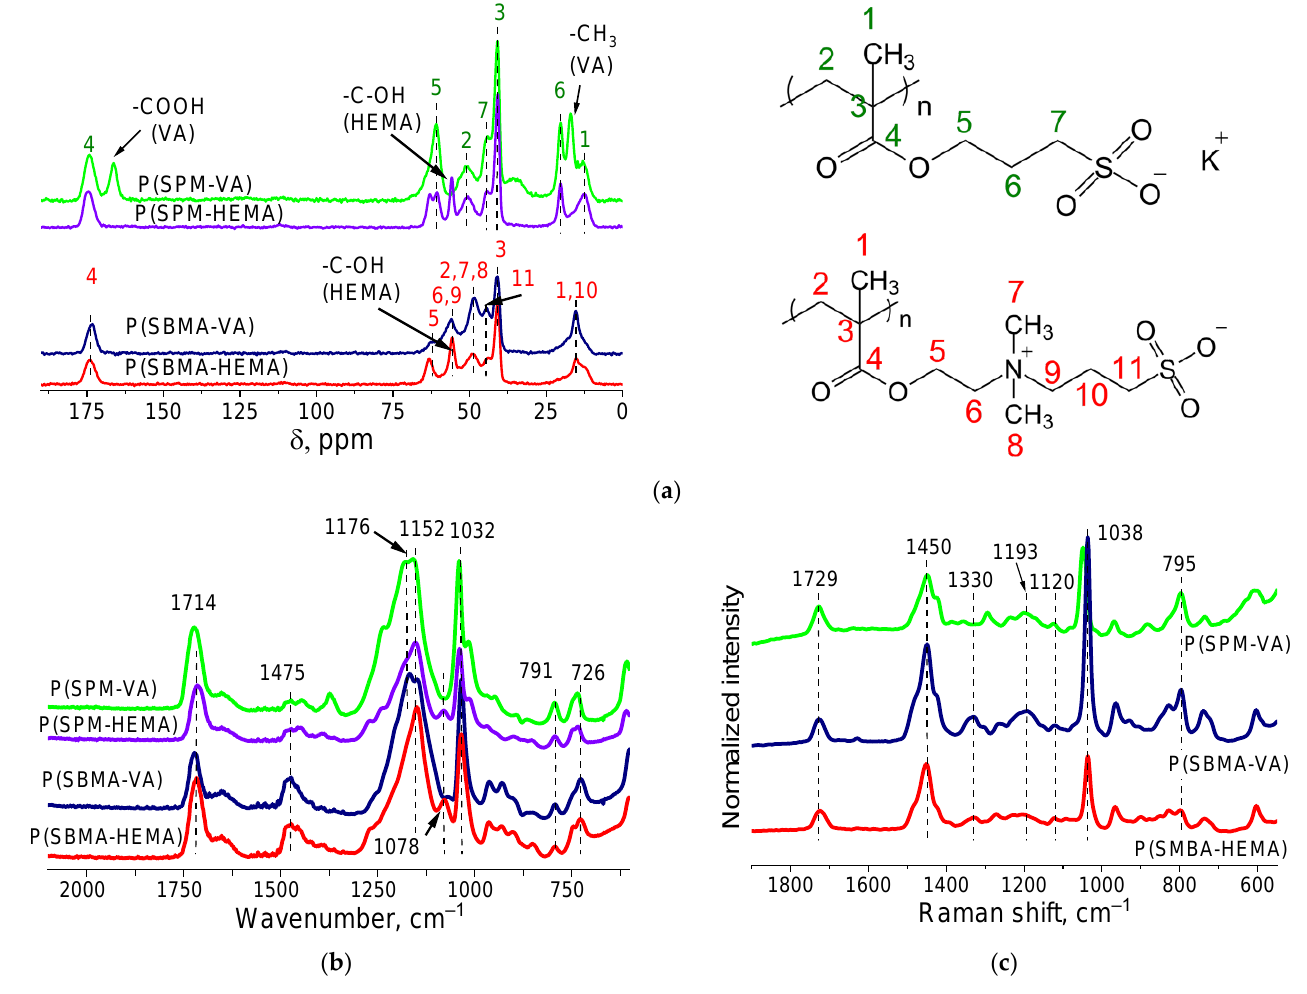
Figure 2. CP/MAS 13 C NMR ( a ), ATR-FTIR ( b ), and Raman Spectra ( c ) of P(SPM-VA), P(SPM-HEMA), P(SBMA-VA), and P(SBMA-HEMA) gels.